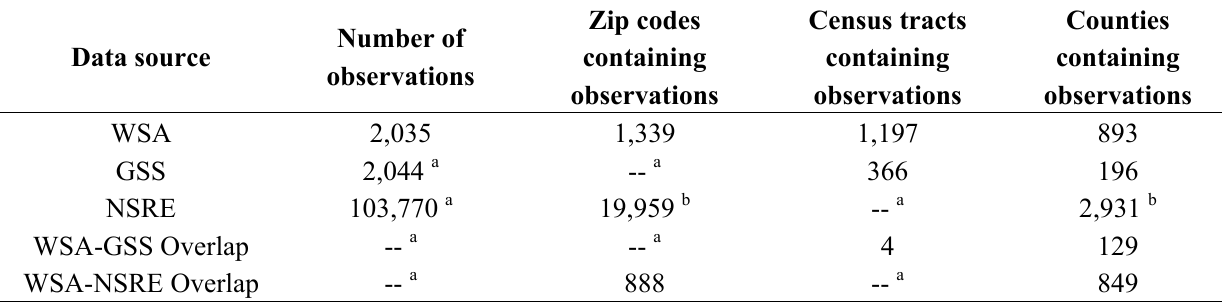
Table 3. Spatial congruence of observations for WSA, GSS,